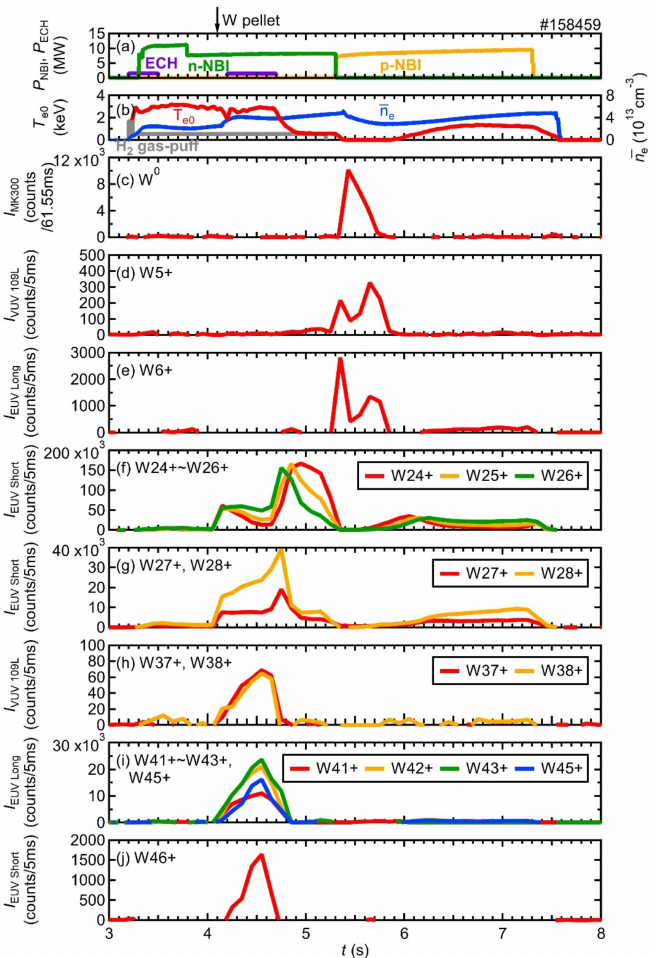
Figure 8. Temporal evolution of ( a ) heating power of ECH, n-NBI, and p-NBI, ( b ) central electron temperature and line-averaged electron density, and W 0 –W 46+ intensities integrated over wave- length ranges of ( c ) 3426.2–3427.9 Å for W 0 , ( d ) 637.8–641.2 Å for W 5+ , ( e ) 261.0–261.5 Å for W 6+ , ( f ) 32.15–32.30 Å for W 24+ , 30.73–31.69 Å for W 25+ , 29.29–30.40 Å for W 26+ , ( g ) 28.58–28.69 Å for W 27+ , 27.35–27.78 Å for W 28+ , ( h ) 645.3–647.1 Å for W 37+ , 558.6–560.3 Å for W 38+ , ( i ) 131.0–131.3 Å for W 41+ , 129.2–129.5 Å for W 42+ , 126.1–126.5 Å for W 43+ , 126.9–127.3 Å for W 45+ , and ( j ) 7.89–7.95 Å for W 46+